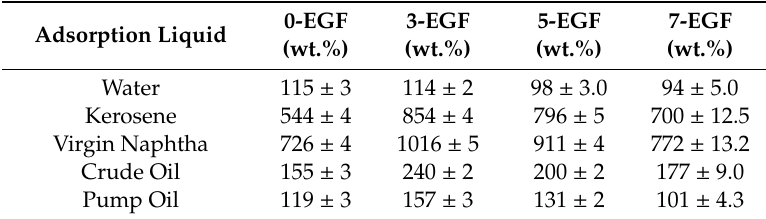
Table 5. Sorption performances in di ff erent liquids of all composite silicone